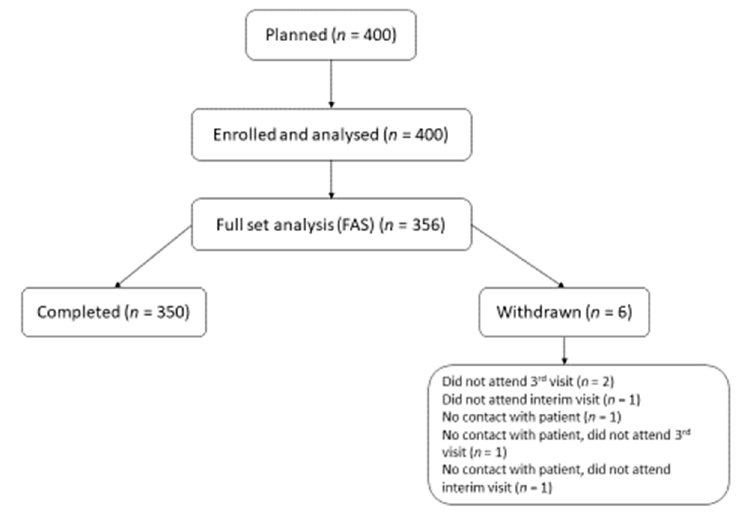
Figure 1. Flow chart of the study population.